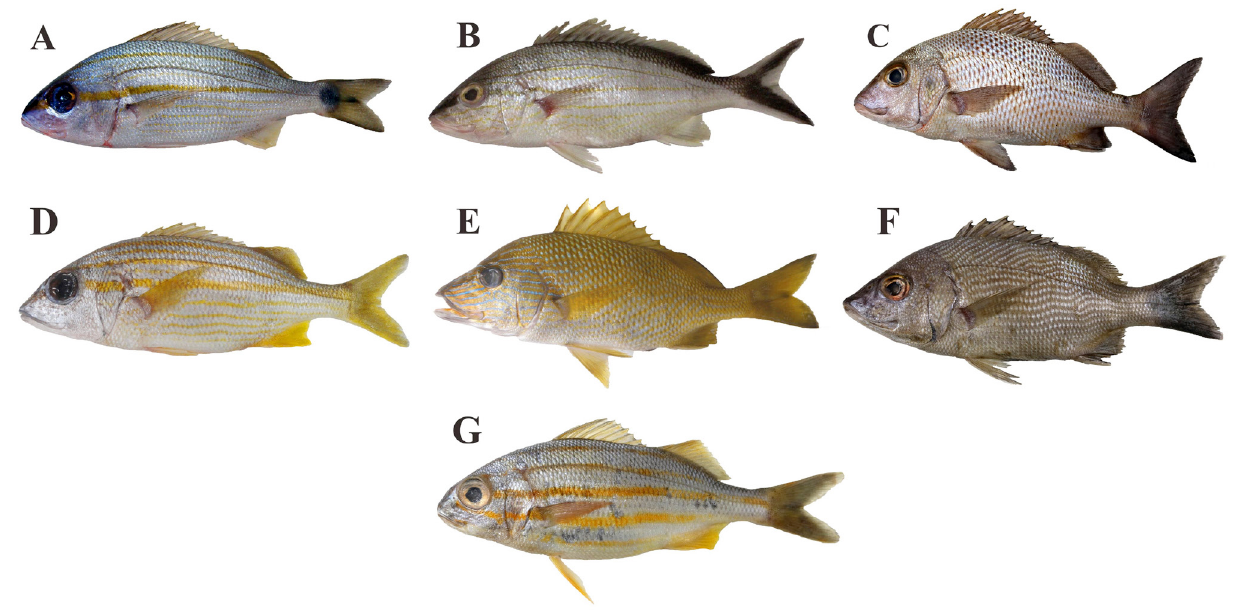
FIGURE 1 | Species of the genera Haemulon and Brachygenys collected off the coast of Brazil during this study. A . Haemulon aurolineatum (16.2 cm of Total Length, TL); B. H . melanurum (18.3 cm of TL); C. H. parra (21.7 cm of TL); D. H . squamipinna (15.9 cm of TL); E. H . plumieri (23.5 cm of TL); F. H . atlanticus (16.1 cm of TL); G. Brachygenys chrysargyrea (16.0 cm of